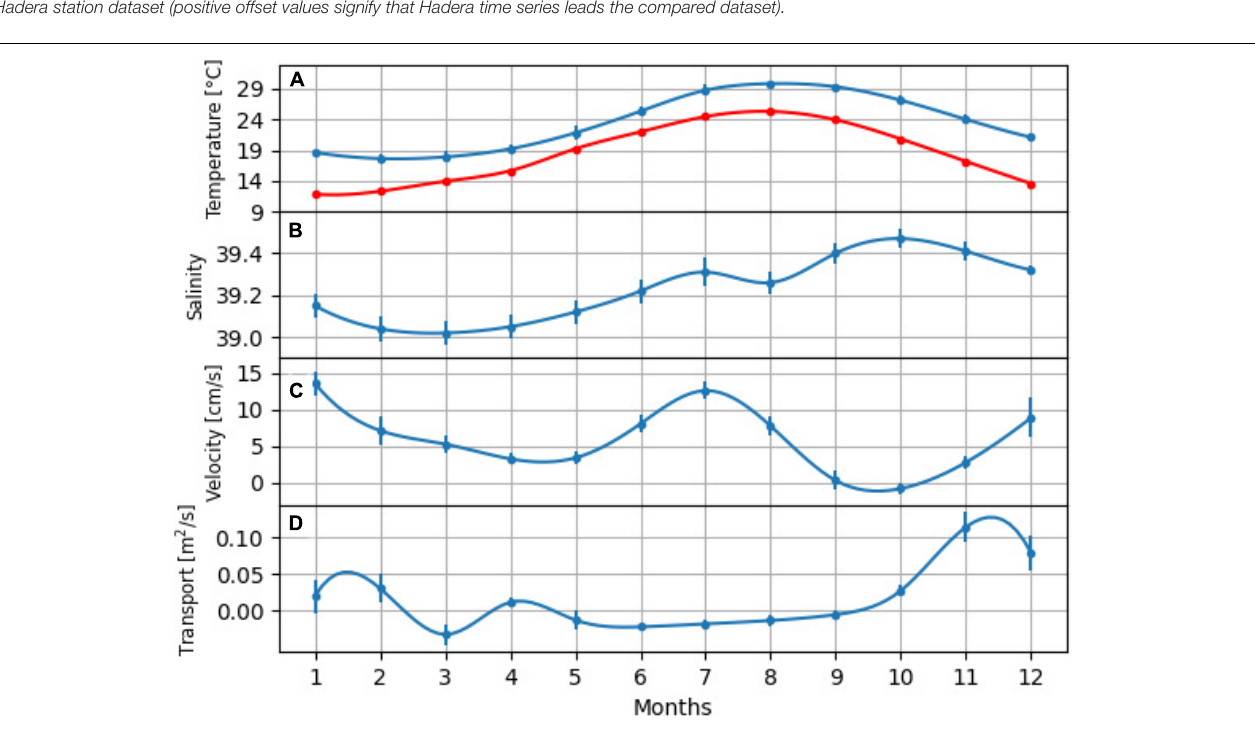
FIGURE 7 | Climatological water temperature ( A , blue), air temperature ( A , red), salinity (B) , along shore current component (C) , and along shore Ekman transport (D) . Standard error of averages shown in Vertical